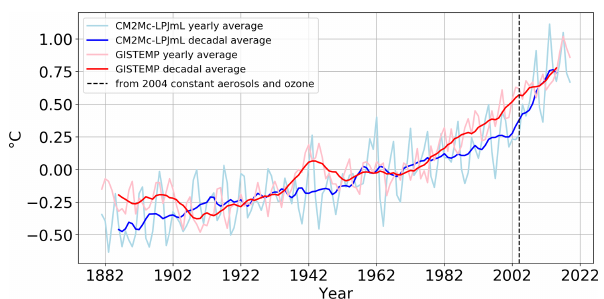
Figure 5. Yearly and decadal global mean temperature anomaly (relative to the 1951–1980 reference period) of the TR experiment of CM2Mc-LPJmL compared to GISTEMP data from 1880 to 2018. Note that, from 2004 on, only greenhouse gas forcing remains, while aerosols, solar radiation and ozone are set to their correspond- ing 2003 values.